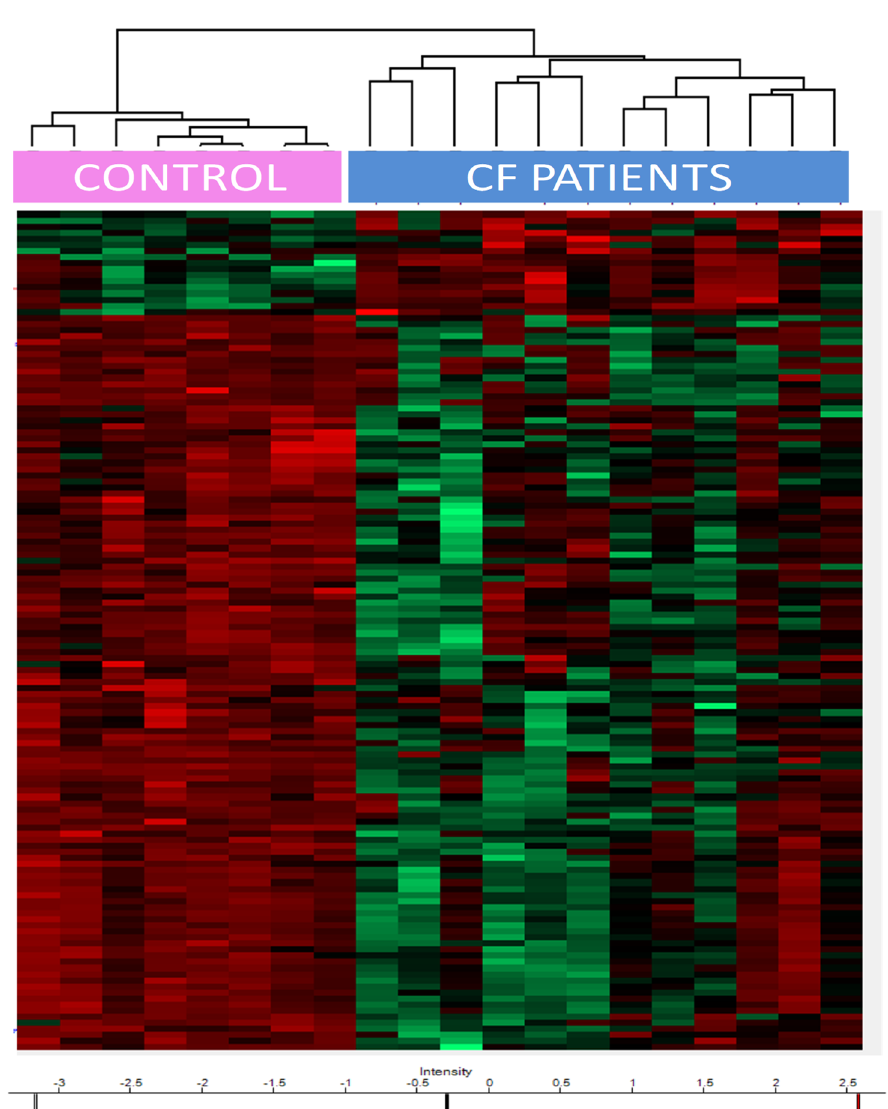
Figure 2. Heatmap of the exosomal proteins differentially expressed between CF patients and healthy controls. Lower and higher values than the mean are represented in green and red scale, respectively.